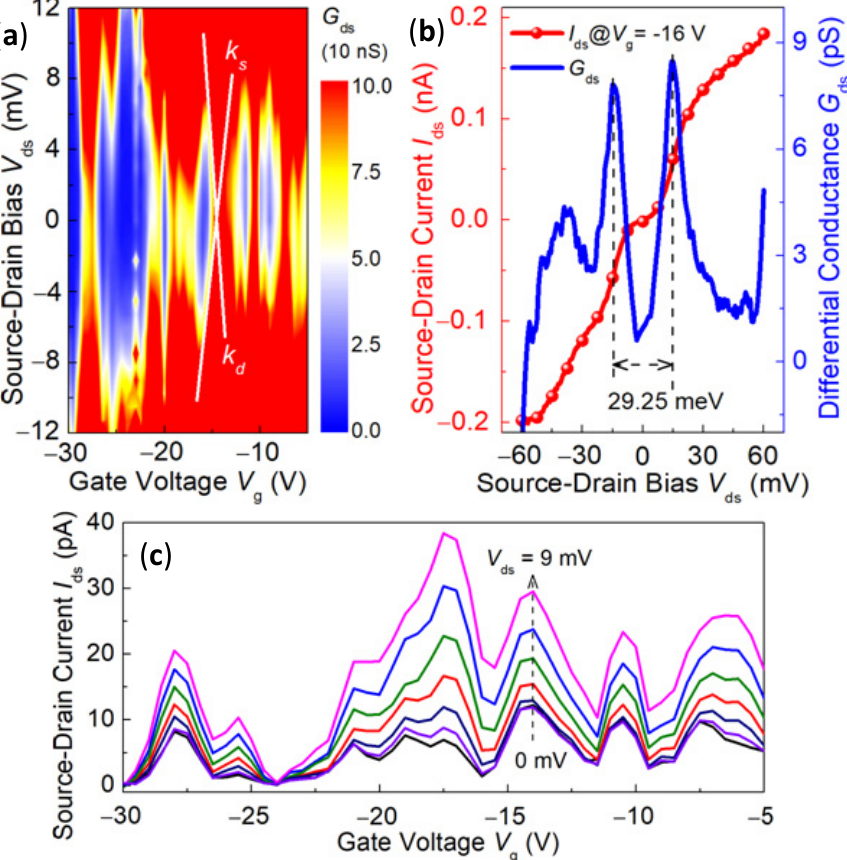
Figure 5. ( a ) Source–drain differential conductance as a function of source drain bias V ds and gate bias V g at T = 320 mK; ( b ) The measured source–drain current curve and its corresponding differential conductance when gate voltage was set at − 16 V; ( c ) The measured source-drain current curve as a function of gate bias V g , when source drain bias V ds was set at different valuea, from bottom to top of 0 mV to 9 mV.